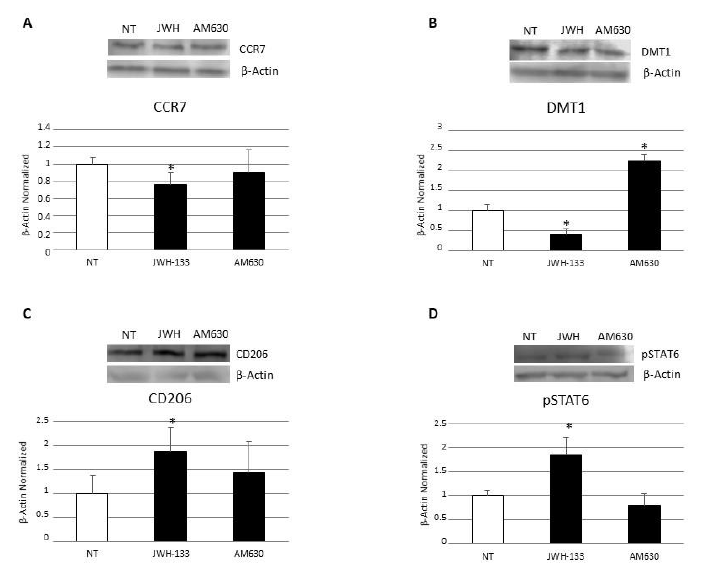
Figure 4. Effects of CB2 modulation on CD macrophages polarization. CCR7 ( A ), DMT1 ( B ) CD206 ( C ) and pSTAT6 ( D ) protein expressions, determined by Western Blot, loading 15 μg of total lysate, in macrophages from 5 celiac disease (CD) patients after JWH-133 [100 nM] and AM630 [10 µM] administration for 48 h. The most representative images are displayed. Image Studio Digits software has been used to detect protein bands. The intensity ratios of immunoblots compared to CTR, con- sidered 1, were quantified after normalizing with respective controls. The histograms represent the relative quantification for CCR7, DMT1, CD206 and pSTAT6 expression, normalized for the house- keeping protein β -Actin, as mean ± SD of independent experiments on each individual sample. A t- test has been used for statistical analysis. * Indicates p ≤ 0.05 compared to NT.